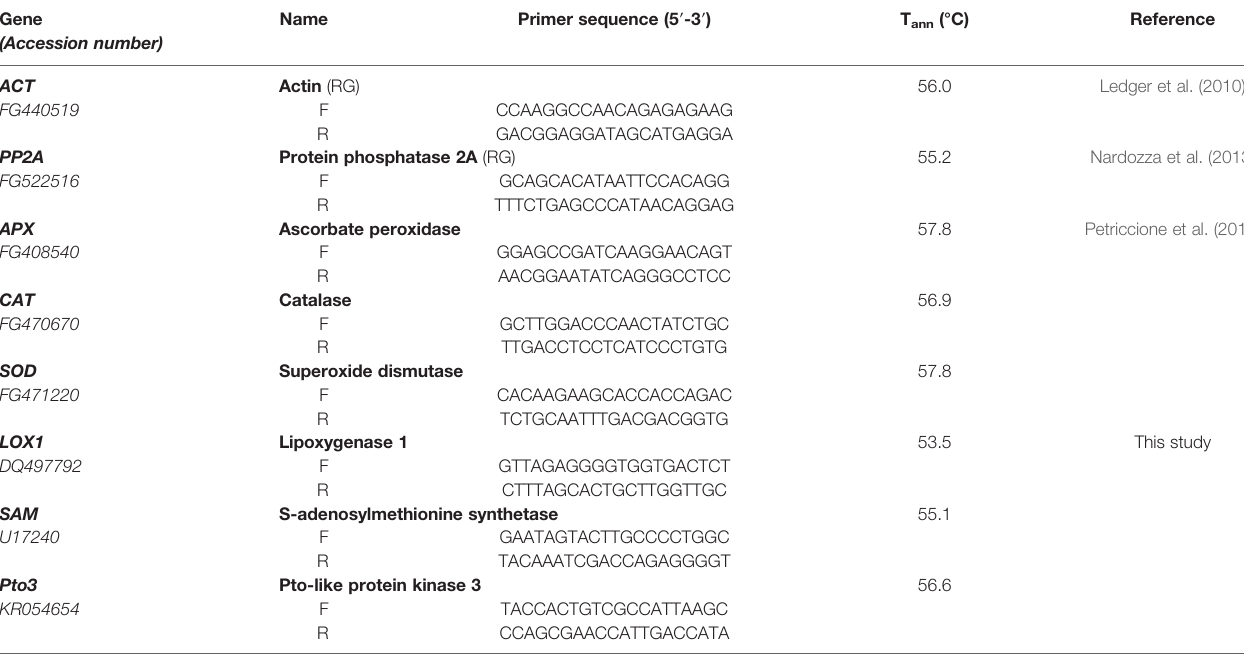
TABLE 1 | Primer sequences (Forward — F and Reverse — R) and annealing temperature of reference genes (RG) and target genes used for RT-qPCR